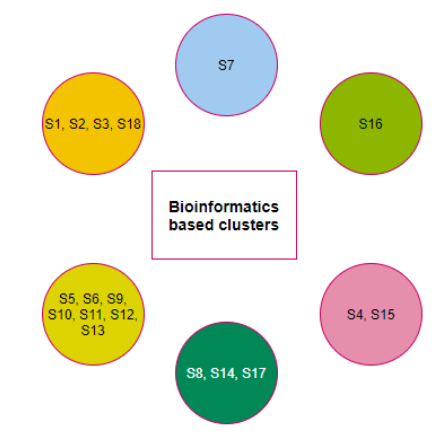
Figure 10. Clusters of species based on the bioinformatics of the D1, D2, and D3